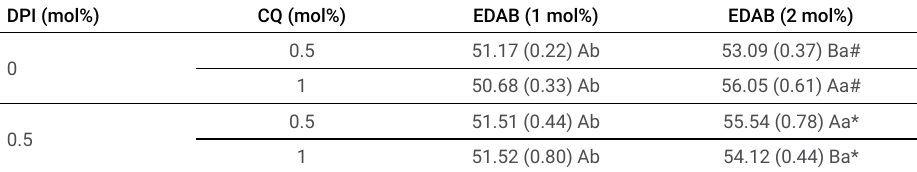
Table 1. Means (standard deviations) for DC (%) DPI